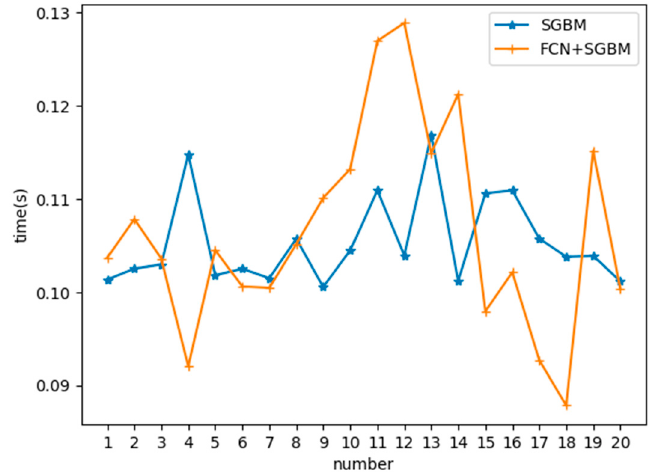
Figure 20. Time in the method of semi-global block matching (SGBM) and combination of SGBM and fully convolutional network (FCN).